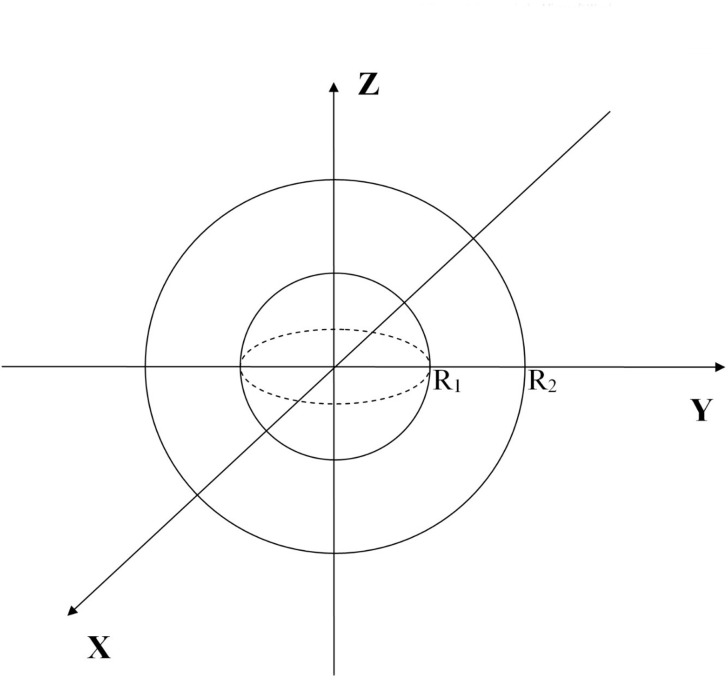
The inner sphere of radius R1 corresponds to a cryoprobe surface having a predetermined temperature T1.The outer sphere of radius R2 defines the surface inside the medium on which a constant temperature T2 is maintained, as determined by the equilibrium state of the heat balance with the environment, an unlimited heat reservoir in the case of a non-living environment surrounding the applicator and a condition of homeostasis in the case of an environment in a living organism.